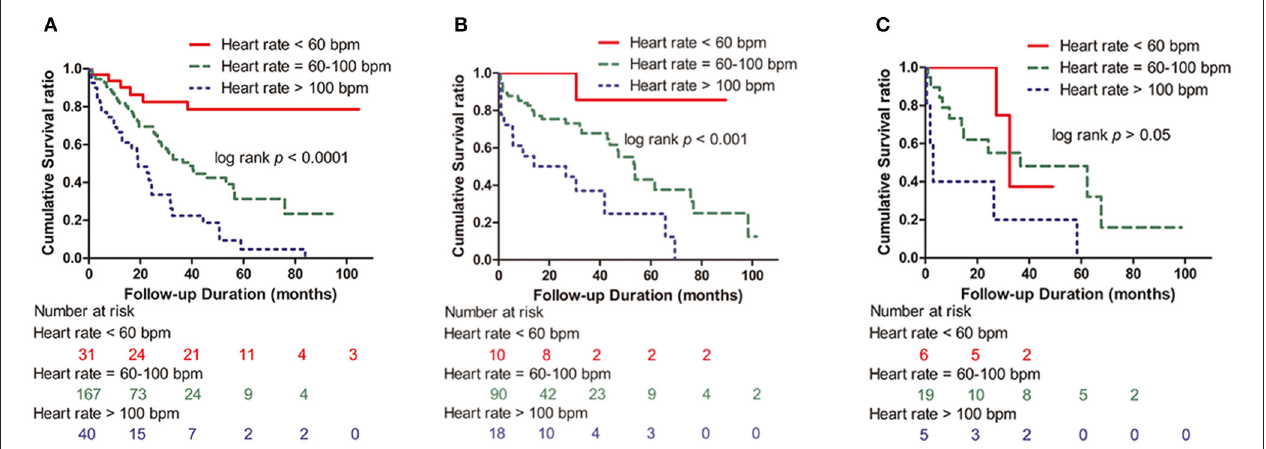
FIGURE 4 | Kaplan–Meier survival curves according to the presence of HR > 100 bpm, 60 ≤ HR ≤ 100 bpm, and HR < 60 bpm in the age groups. (A) Age < 65 years group (log-rank p < 0.0001). (B) Age 65–75 years group (log-rank p < 0.001). (C) Age > 75 years group (log-rank p > 0.05). HR, heart rate; bpm, beats per minute.